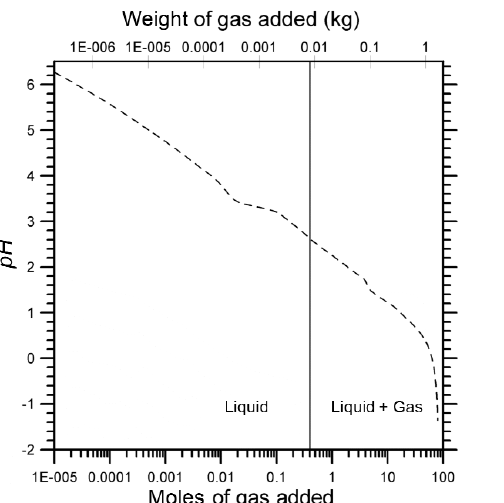
Fig. 8. Changes in dissolved sulfur species during the progressive addition of hot (915°C) magmatic gas into 1000 g of pure water initially at 25°C. Pressure was kept at 0.1 MPa throughout the simu-